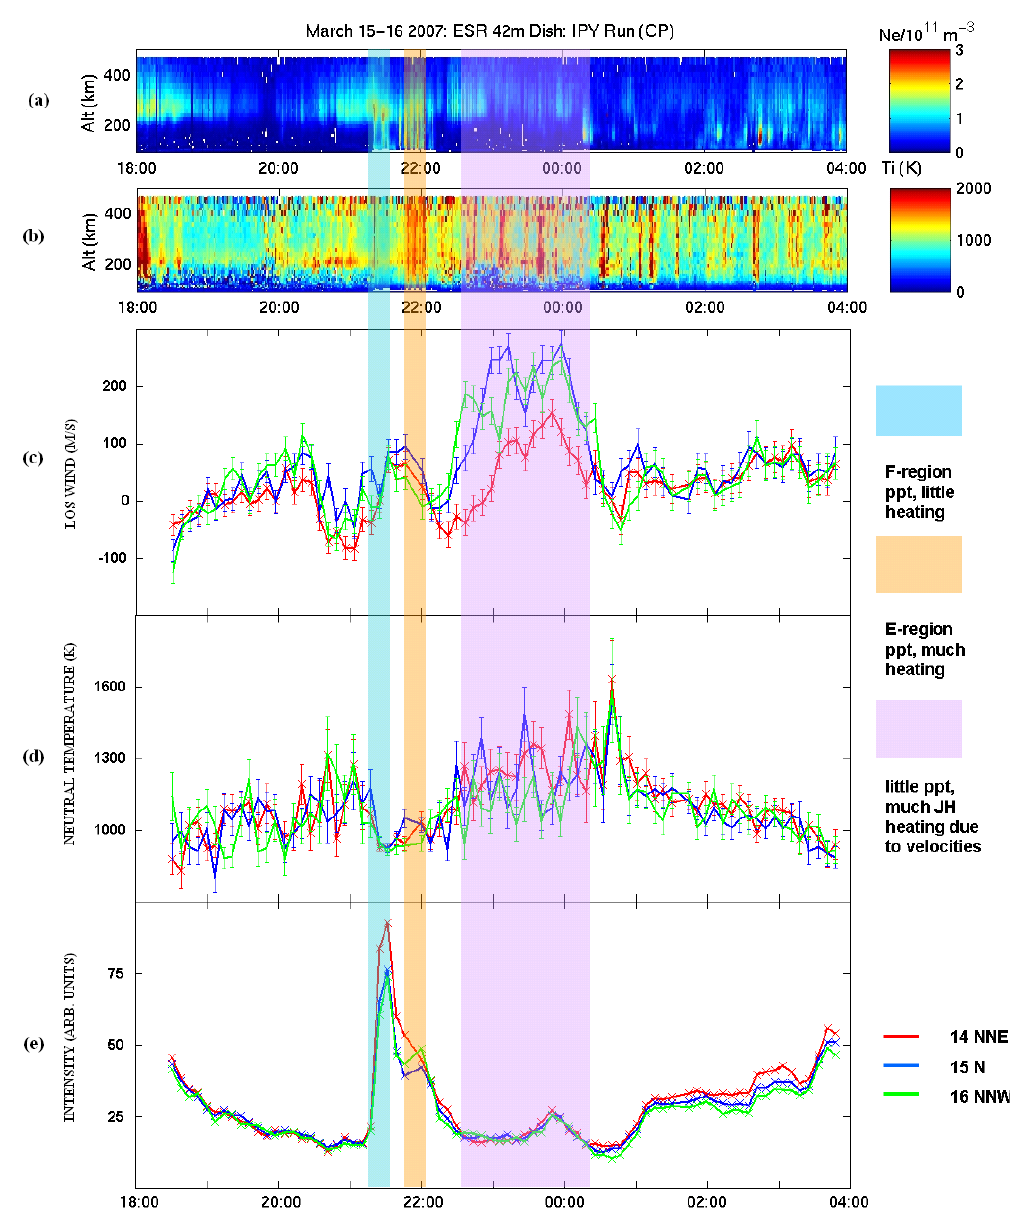
Fig. 3. ESR Ion temperatures and electron densities (panels a and b , respectively) compared with SCANDI LOS winds, neutral temperatures and intensities (panels c , d and e , respectively) for zones 14 (red), 15 (blue) and 16 (green) as shown in Fig.